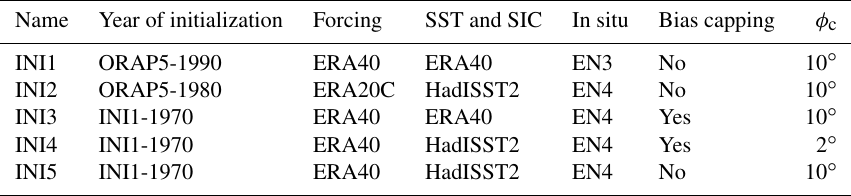
Table 2. Ensemble of ORAS5 initial conditions Name Year of initialization Forcing SST and SIC In situ Bias capping φ c INI1 ORAP5-1990 ERA40 ERA40 EN3